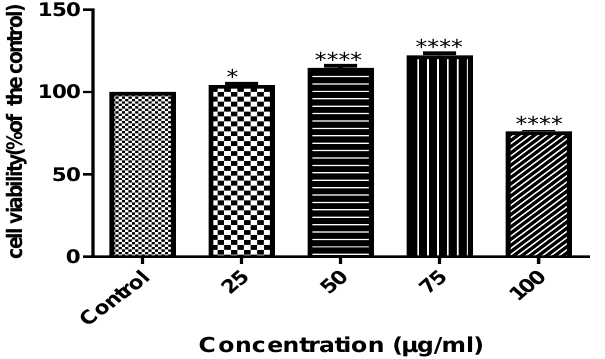
Figure 3. Cytotoxic screening of AAHPE at different concentrations. Values are expressed as the mean ± SD ( n = 3), * p < 0.05 and **** p < 0.0001 compared with the control.